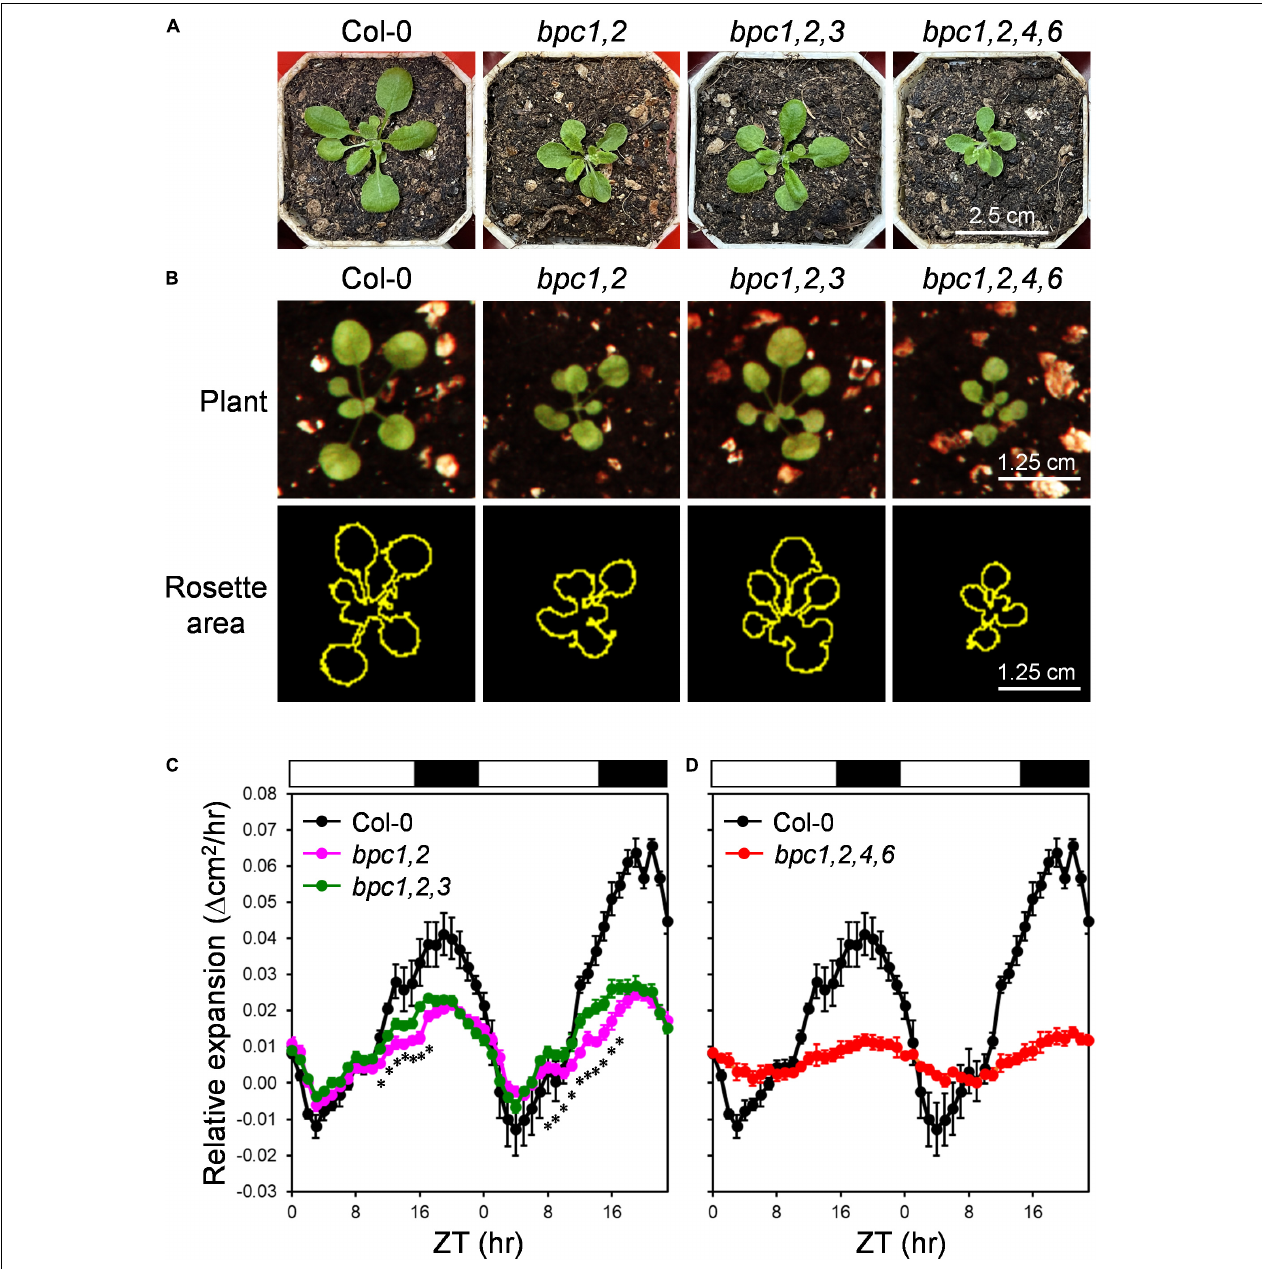
FIGURE 1 | BPC3 antagonized the circadian growth during the vegetative stage. (A) Plants representing wild-type (Col-0), bpc1,2 , bpc1,2,3 and bpc1,2,4,6 grown under the long-day condition (16-h light/8-h dark, 45–55 mmol m − 2 s − 1 ) was photographed on day 21 for the size comparison. (B) The hour-growth of the indicated plants was image recorded (upper panel) and outlined by using the tracing tool of ImageJ 1.53c (yellow outlines, lower panel) to project the rosette area. (C,D) Relative expansion of rosette area was measured for each plant line from zeitgeber time 0 (ZT 0) on day 14 to ZT 23 on day 15 based on pixel quantitation of plant outlines. Rosette area across ZT points with a 10-ZT sliding window was averaged to lower leaf movement and nutation effects on the area. Data are mean ± S.E. ( n = 7–9). Asterisks indicate ZTs on which the expansion rate of bpc1,2,3 was significantly different from that of bpc1,2 (Student’s t- test; ∗ P < 0.01; n = 9). The expansion rate of Col-0 was duplicated in (C,D) for comparisons with bpc mutants in plot charts. White and black bars indicate the light and dark periods.